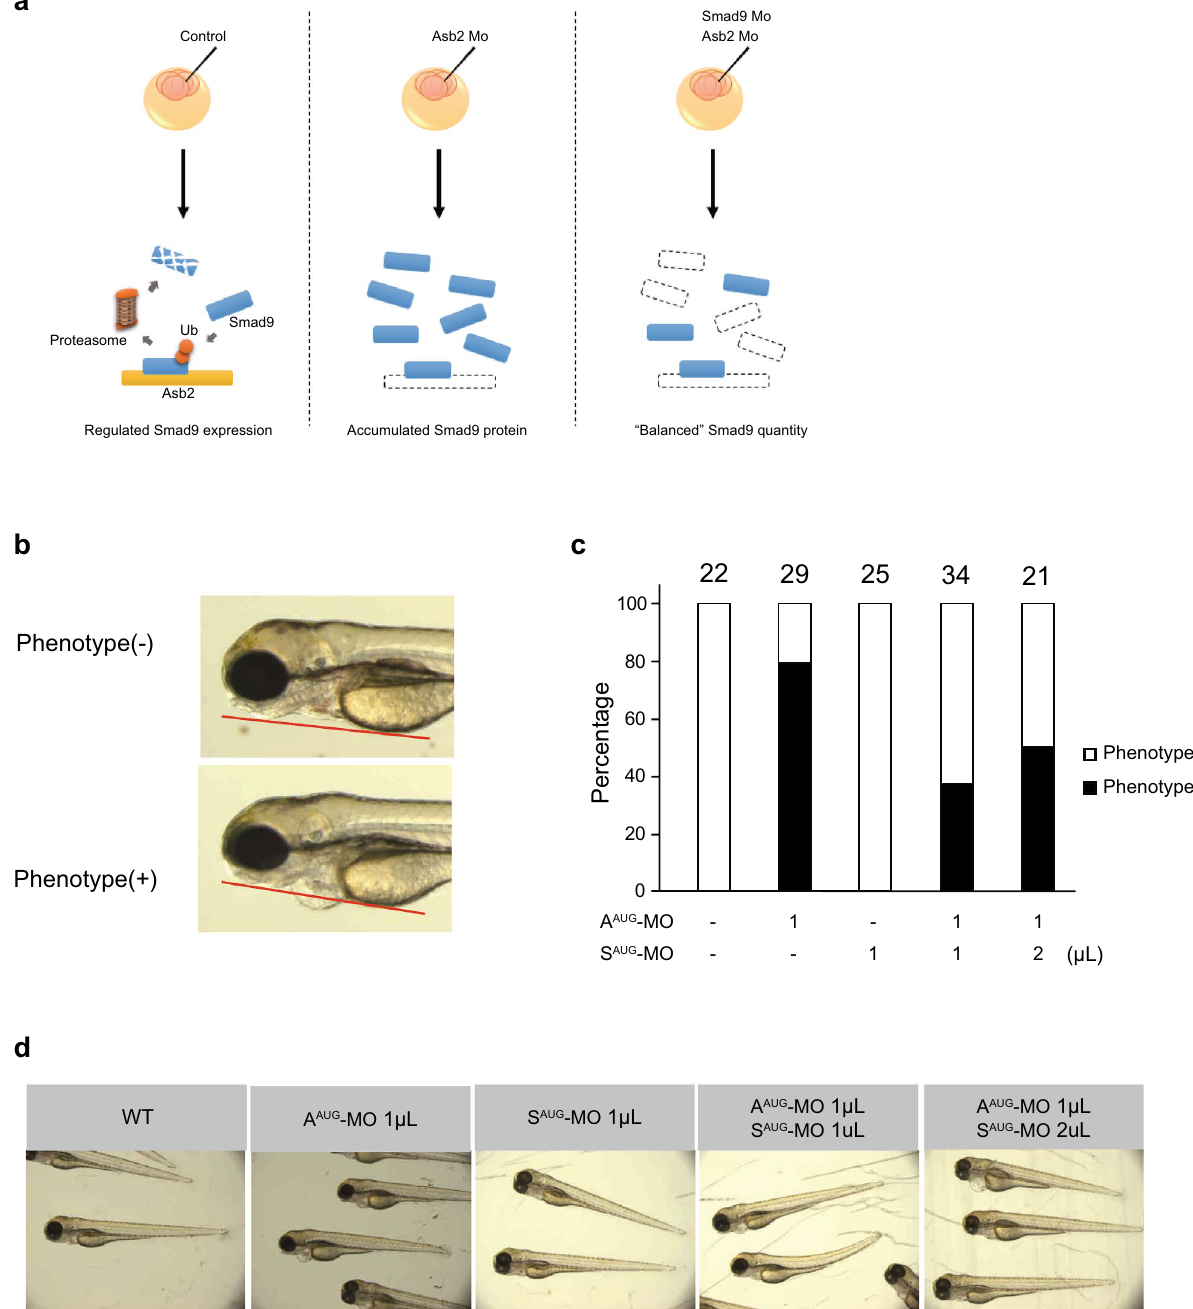
Figure 5. The phenotype of Asb2 knockdown is rescued by simultaneous knockdown of Smad9. ( a ) Scheme of the experimental hypothesis. The balanced amount of Smad9 protein is enabled by expression as well as degradation of Smad9. The injection of Asb2 Mo may result in loss of active degradation of Smad9 protein leading to the accumulation of Smad9. Simultaneous knockdown of Asb2 and Smad9 may attenuate the accumulation of Smad9 protein. Therefore, MO targeting the start codon of Asb2 (A AUG -MO) and/or Smad9 (S AUG -MO) was injected into zebrafish embryos at the 2–4 cell stage. At 72 hpf, the phenotype of the embryos was determined. ( b ) The cardiac phenotype was determined to be positive when the pericardium showed remarkable swelling over the tangent line of yolk and mandible. ( c ) The ratio of embryos with positive (black) and negative (white) phenotypes. The number of the animals is shown above each bar. ( d ) Representative animals of each group. No obvious phenotype was detected in any